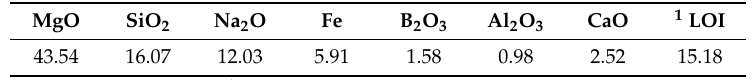
Table 1. Main chemical composition of MgO-enriched non-magnetic material (wt %).